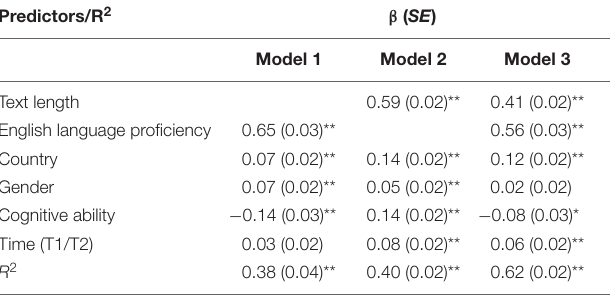
TABLE 1 | Linear regression of text quality on text length, English language proficiency, and control variables: standardized regression coefficients ( β ) and standard errors